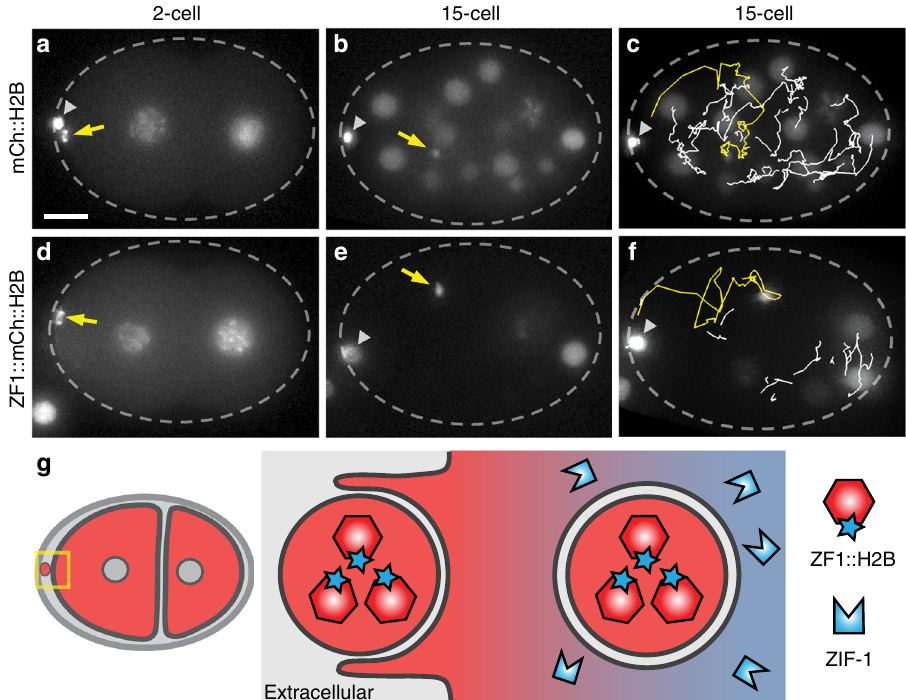
Fig. 5 Degron reporters label phagocytosed cell debris and enable tracking. a – c The histone reporter mCh::H2B labels chromosomes in embryonic nuclei and two polar bodies ( n = 13). The fi rst polar body (arrowhead) is trapped in the eggshell (dashed oval). Scale bar: 10 µ m. a The second polar body (2PB, arrow) neighbours the anterior blastomere (AB cell) in a two-cell embryo. b The 2PB is engulfed in a phagosome in a 15-cell embryo. Due to H2B fl uorescence from surrounding embryonic nuclei, it is hard to track the 2PB. c Automated tracking of the 2PB (yellow) results in crossing tracks from nearby nuclei (white), increasing the potential need for manual correction. d – f Embryos labelled with ZF1-tagged mCh::H2B ( n = 12). d The released 2PB neighbours a two-cell embryo. e After engulfment, the 2PB is easily trackable due to degradation of ZF1::mCh::H2B in somatic cell nuclei. See also Supplementary Movie 3. f Automated tracking of the 2PB (yellow) is simpli fi ed by removing the label of nearby nuclei (white). g Degron reporters released in cells or other debris prior to expression of the ZIF-1 ubiquitin ligase adaptor are protected from ZF1-mediated degradation. After engulfment in a second layer of membrane, they are still protected from proteasomal degradation. As degron reporters are degraded in the cytosol, only the reporters within the phagosome remain fl uorescent, improving the signal-to-noise ratio